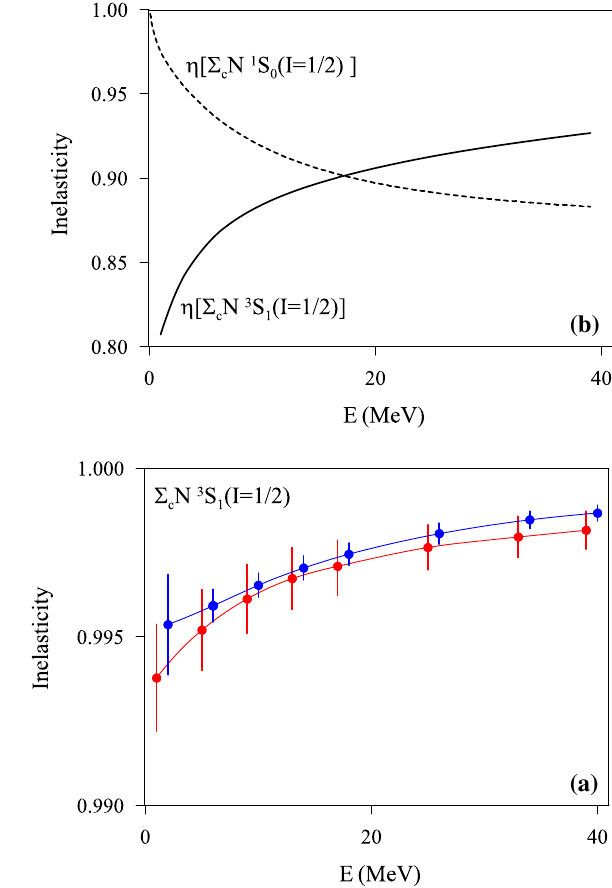
Fig. 6 a Inelasticity for the (cid:3) c N 1 S 0 ( I = 1 / 2 ) and (cid:3) c N 3 S 1 ( I = 1 / 2 ) partial waves predicted by the CQM as a function of the c.m. kinetic energy. a Inelasticity for the (cid:3) c N 3 S 1 ( I = 1 / 2 ) partial wave of the HAL QCD Collaboration [45] at m π = 570 MeV (blue filled circles) and m π = 410 MeV (red filled circles) as a function of the c.m. kinetic energy. The vertical line at each point represents the statistical error of the lattice QCD simulations. The solid blue and red lines are just a guide to the